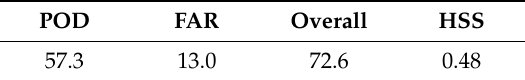
Table 8. Performance statistics of the final logistic regression model. POD indicates the probability of snowfall detection, FAR indicates the probability of false alarm, and HSS indicates the Heidke Skill Score.